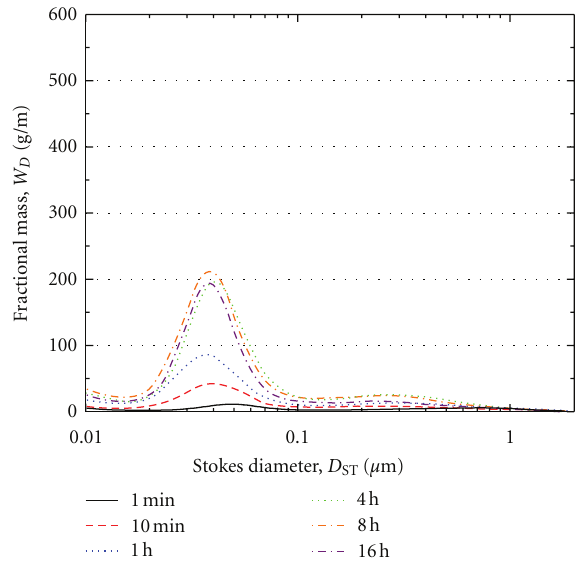
Figure 1: Particle size distributions of Arkema CNTs with increas- ing sonication time in an ultrasonic